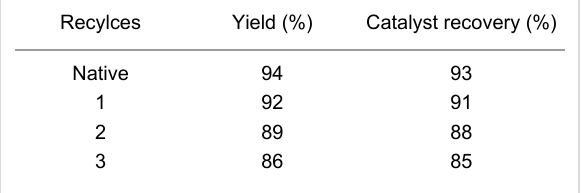
Table 4: Copper oxide reusability of the